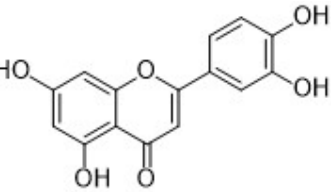
Figure 16. Chemical structure of luteolin (LUT).